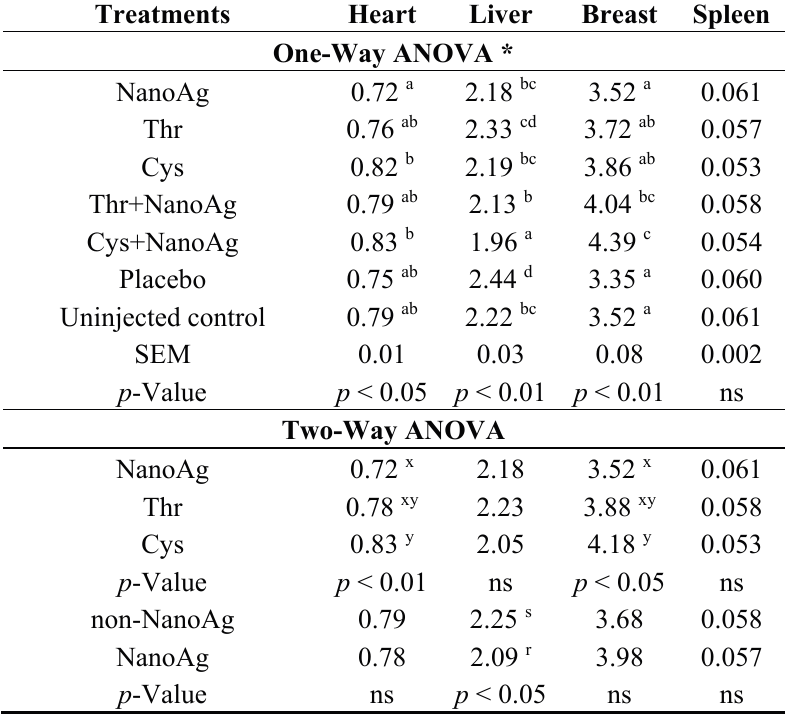
Table 2. Mean internal organ weights of embryo at 19 day of embryogenesis in eggs injected with nanoparticles of silver (NanoAg), threonine (Thr), cysteine (Cys) and their